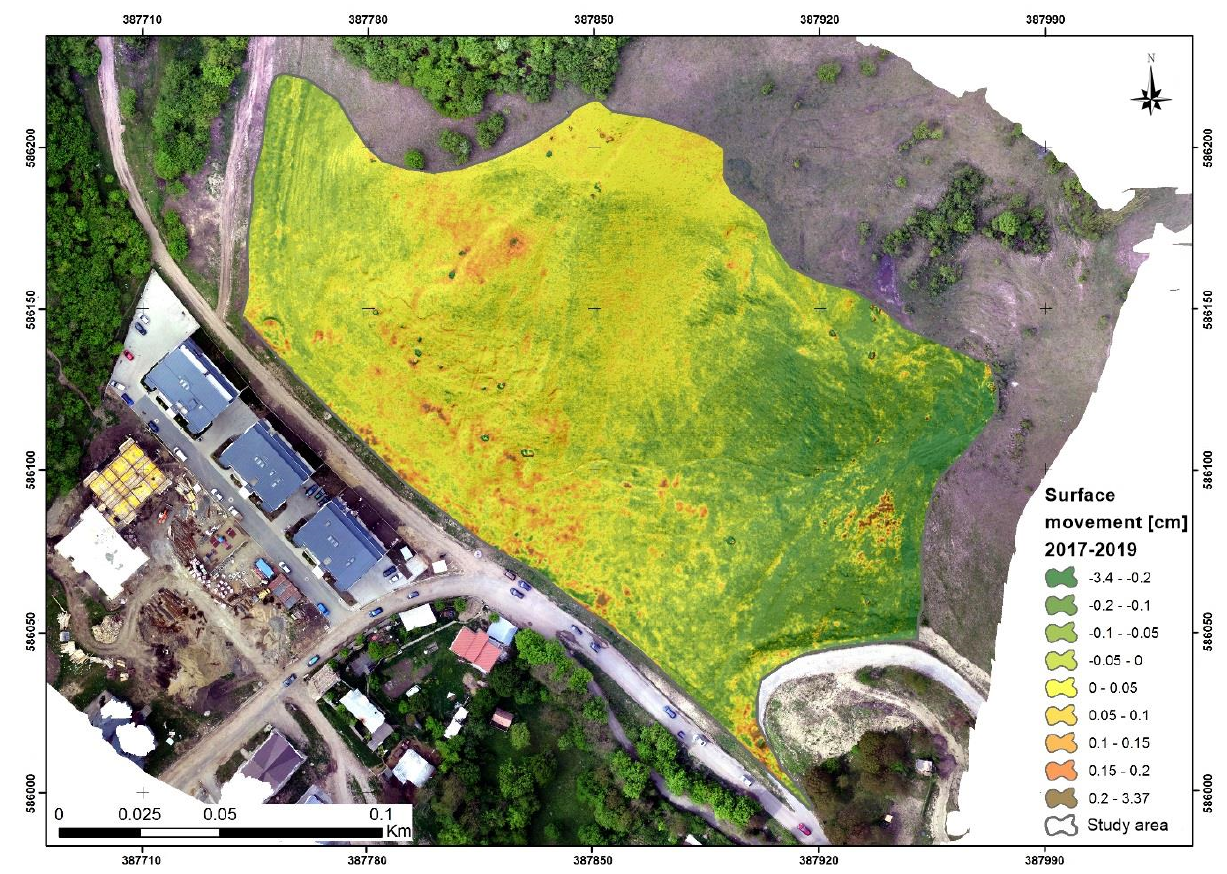
Figure 13. Rate of surface movement between 2017 and 2019.